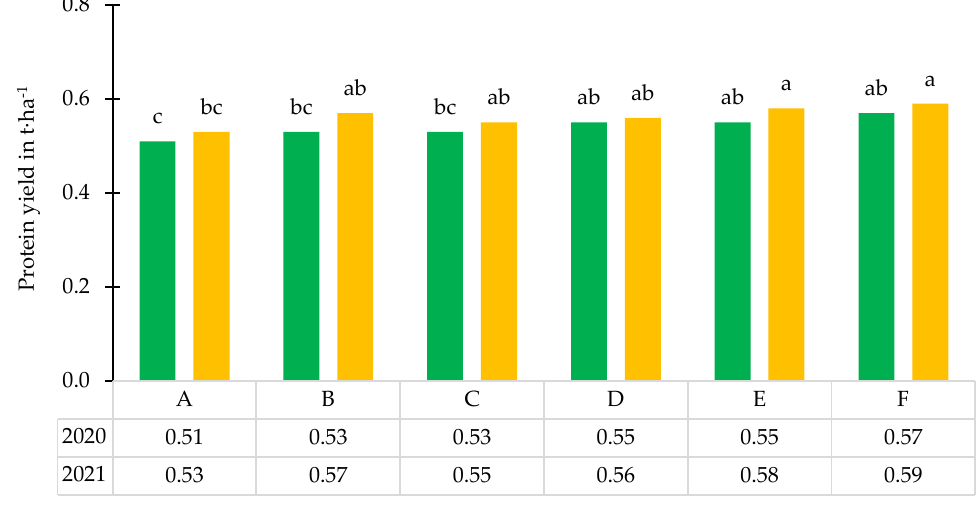
Figure 8. Protein yield in t · ha − 1 . A–F—variants of fertilization. Different lowercase letters indicate significant differences ( p < 0.05) according to the analysis of variance (ANOVA).